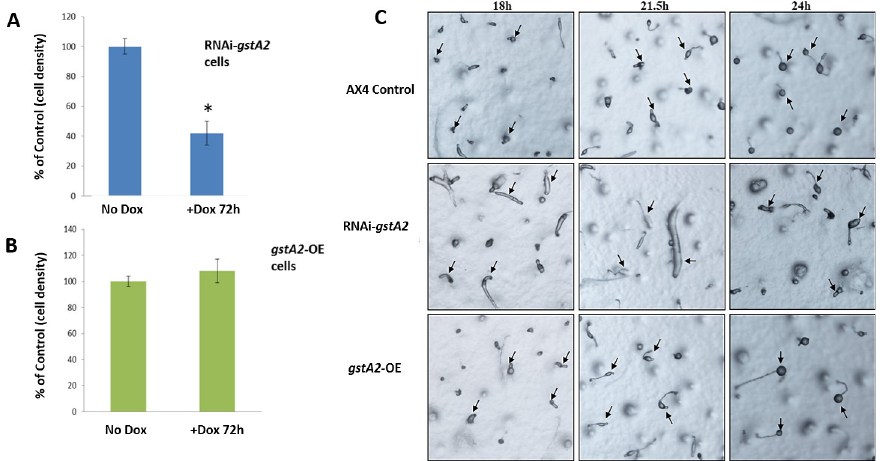
Fig 9. Effect of knock-down (A) and overexpression of DdGSTA2 on the proliferation and development of D . discoideum . (A) D . discoideum cell proliferation was decreased by 60% at the end of 72 hours (doxycycline-induced) gstA2 -knockdown cells, whereas (B) overexpression of DdGSTA2 did not significantly affect the proliferation of cells. Histograms represent at least three experiments (n = 3) performed in triplicate (mean ± SD, p < 0.05). (C) Developmental delays were observed in the later stages in RNAi- gstA2 cells as compared to controls. At 18 hours the controls progressed to pre-fruiting body stage whereas RNAi- gstA2 cells were still at slug stage. Pre-fruiting bodies observed in controls at 18 hours progressed to completion by 24 hours. RNAi- gstA2 knockdown caused abnormalities in slug morphology (increased thickness, length, and migration) and stunted, incomplete, and fewer numbers fruiting bodies (at 24 hours). There were no developmental delays observed with DdGSTA2-overexpression when compared to controls.